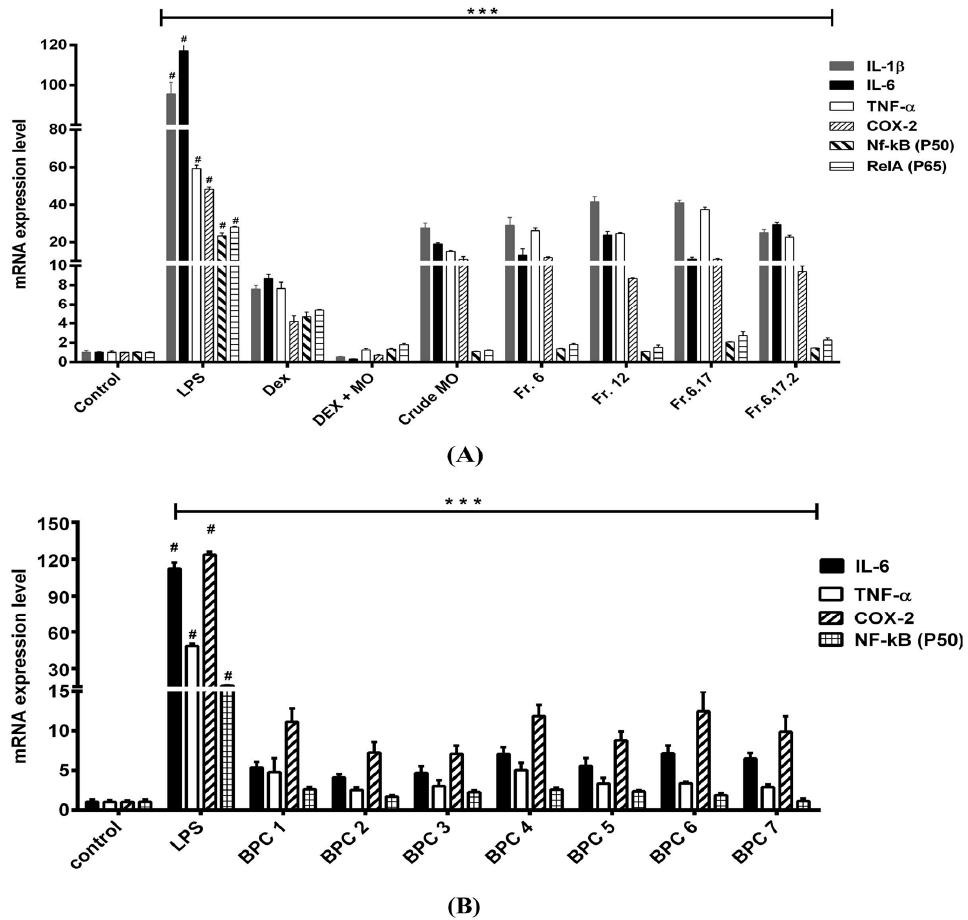
Figure 4. Effect of MO leaves extract on mRNA expression of pro-inflammatory cytokines levels in MDM. The cytokine mRNA expression of treated MO leaves extract and their fractions ( A ) and mRNA expression of 7 micro-fractions collected from a line LC-MS/MS of subfraction 6.17.2 ( B ). Data are presented as means ± SEM. # p < 0.001 compared to control, *** p < 0.001, compared to LPS. Control: Untreated MDM; LPS: Lipopolysaccharide-stimulated MDM; Dex: Dexamethasone; Dex + MO: Combination of Dexamethasone and crude EtOAc; crude MO: ethyl acetate MO; Fr6: Fraction 6; Fr12: Fraction 12; Fr.6.17: Fraction 6.17; Fr.6.17.2: Fraction 6.17.2.; BPC: base peak chromatogram .